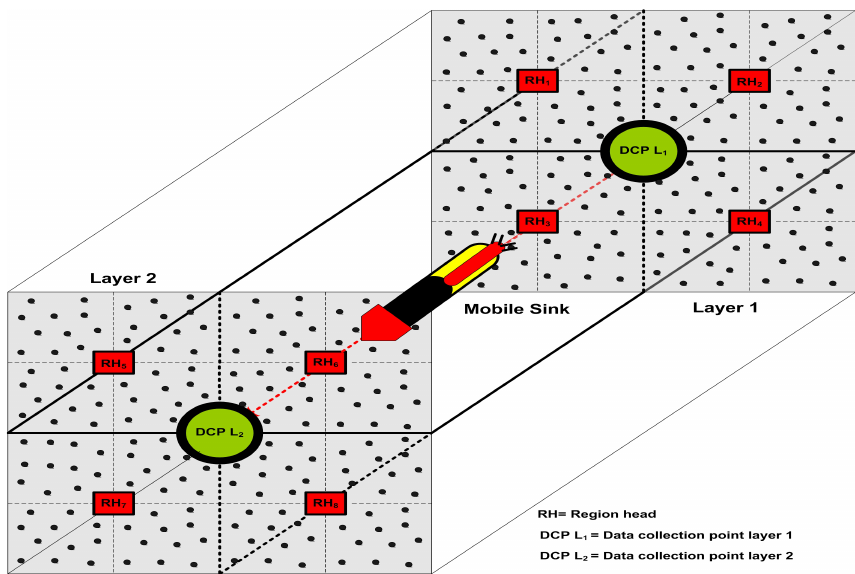
Figure 1. An overview of two-layer hierarchy of the proposed